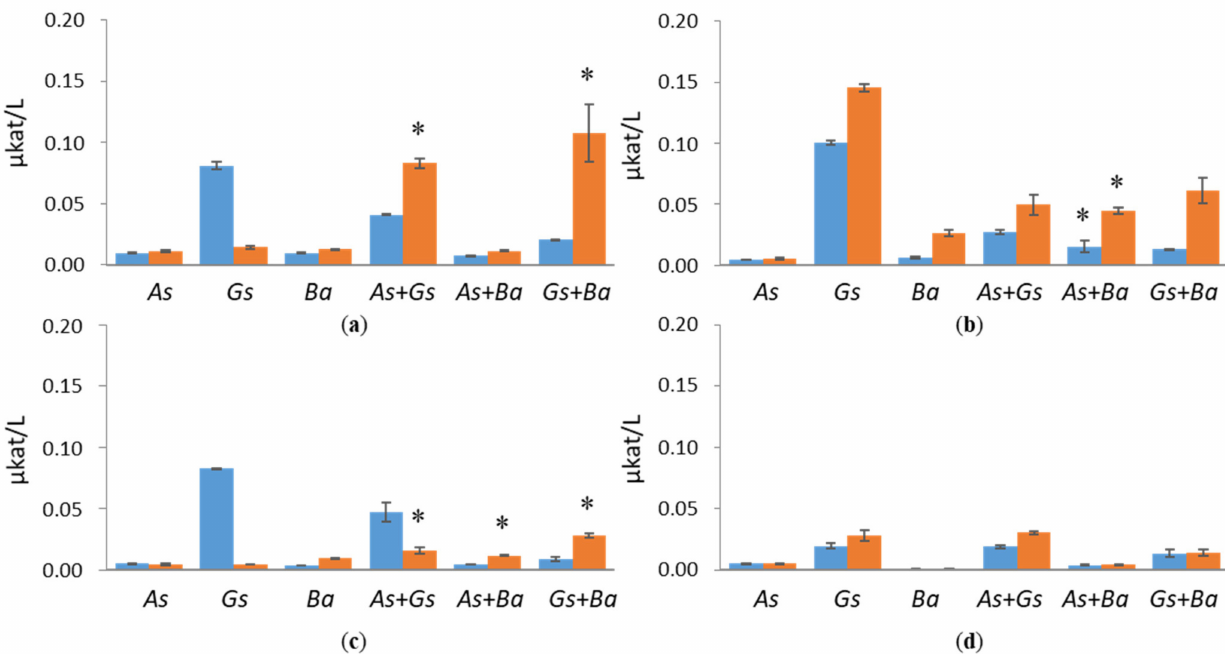
Figure 8. α -galactosidase (AGL) activities at early (day 10, marked in blue) and late time points (day 24, marked in red) in single and co-cultivation on ( a ) birch, ( b ) spruce, ( c ) pine wood and ( d ) Avicel. As = A. sinuosa , Gs = G. sepiarium , Ba = B. adusta , As + Gs = A. sinuosa and G. sepiarium , As + Ba = A. sinuosa and B. adusta , Gs+Ba = G. sepiarium and B. adusta . Error bars refer to standard deviation (SD) ( n = 3). * indicates statistical difference among single and co-cultivations ( p <